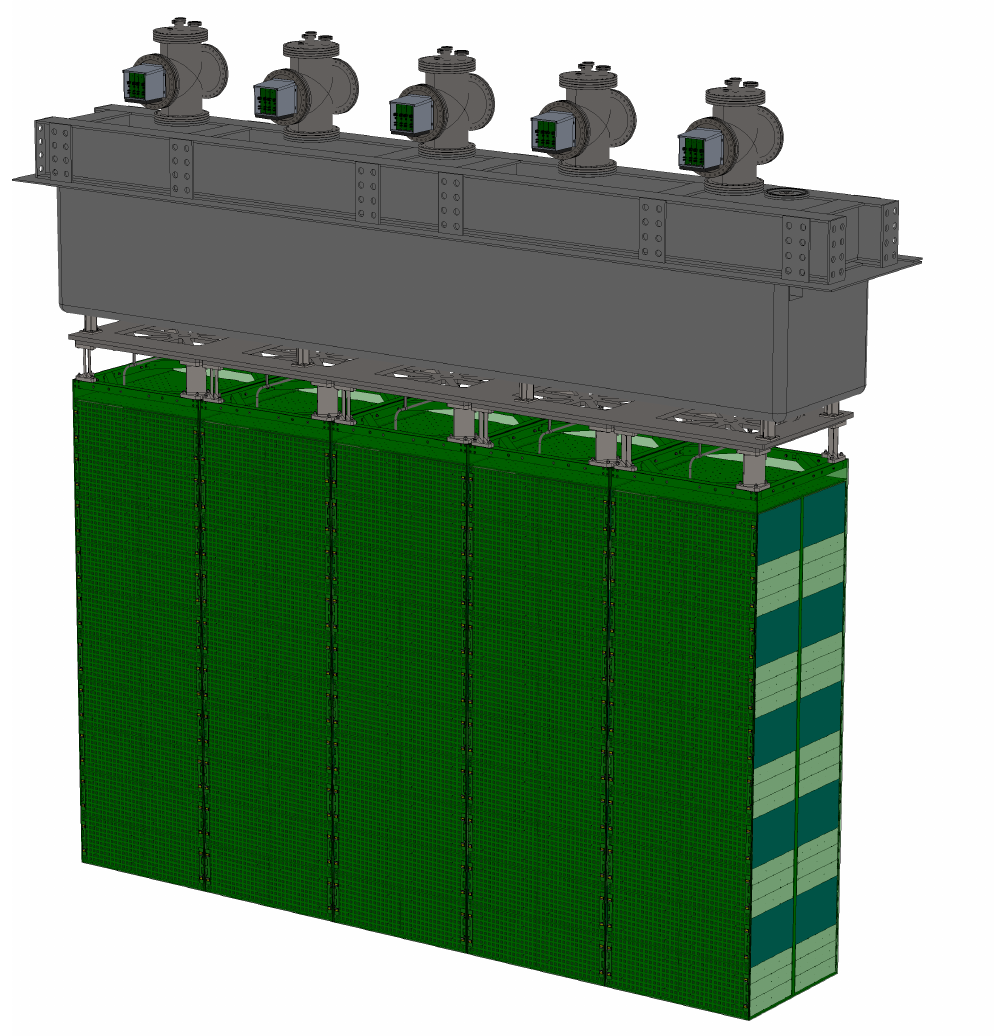
Figure 10. A row of five modules for ND-LAr along with support structure. The top mechanical support acts as a cryostat lid and provides thermal insulation and feed-throughs for power and signals for the 5 modules. The modules visible in the figure are hung from the top